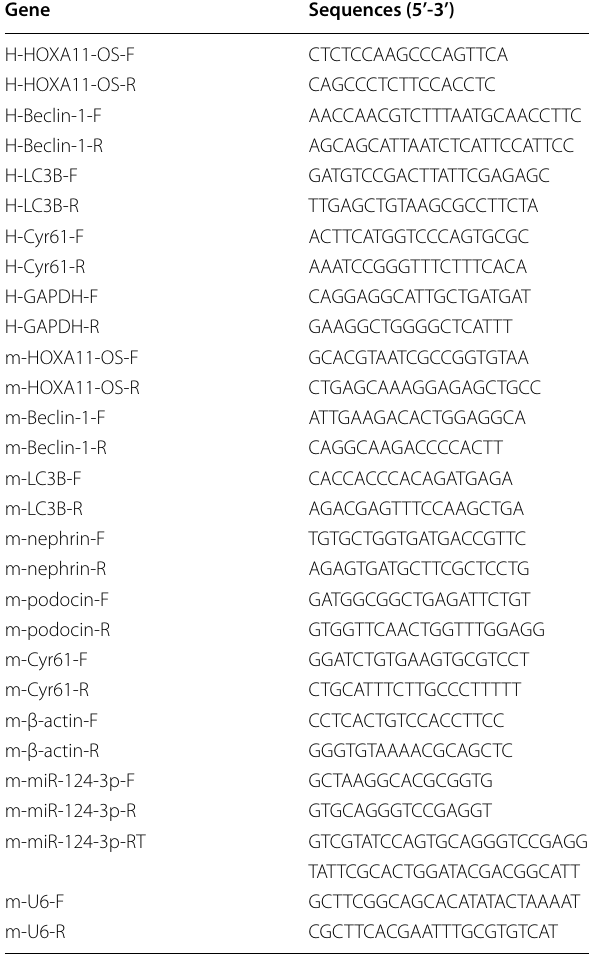
Table 3 qPCR primer